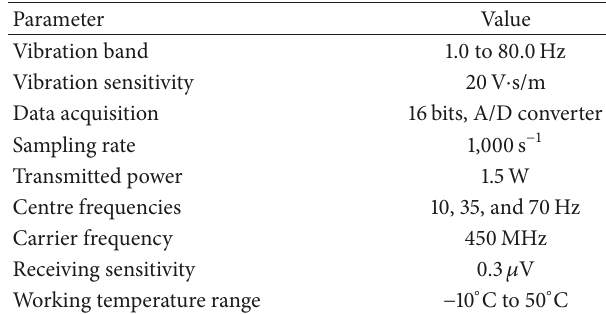
Table 1: Main performance parameters of TDS-6